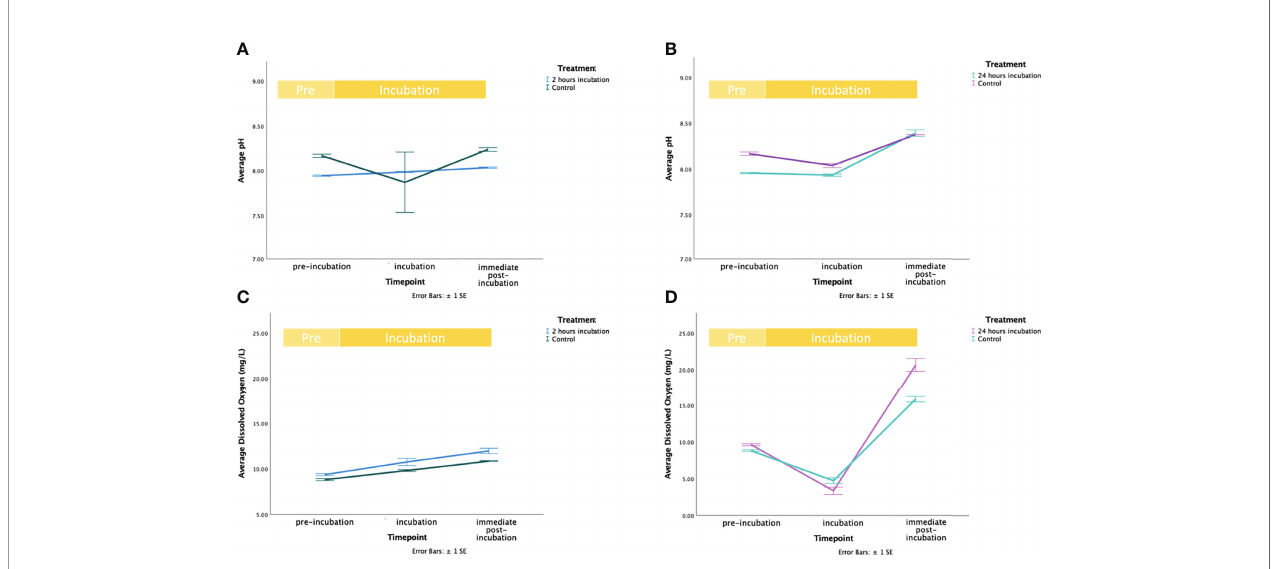
FIGURE 2 | Environmental parameters variation during the exposure of Cassiopea jelly fi sh to Magnesium Chloride (MgCl 2 ). In fi gures a, and c the green line represents the control, and the blue line represents the treatment. In fi gures b, and d, the mint line represents the control, and the purple line represents the treatment. (A) Fluctuations of average pH levels before the start ( “ pre-incubation ” ), middle ( “ incubation ” ) and end ( “ immediate post-incubation ” ) of the 2 hours exposure to MgCl 2 . Bars represent standard error (± 1SE). (B) Fluctuations of average pH levels before the start ( “ pre-incubation ” ), middle ( “ incubation ” ) and end ( “ immediate post-incubation ” ) of the 24 hours exposure to MgCl 2 . Bars represent standard error (± 1SE). (C) Fluctuations of average d O 2 levels before the start ( “ pre-incubation ” ), middle ( “ incubation ” ) and end ( “ immediate post-incubation ” ) of the 2 hours exposure to MgCl 2 . Bars represent standard error (± 1SE). (D) Fluctuations of average d O 2 levels before the start ( “ pre-incubation ” ), middle ( “ incubation ” ) and end ( “ immediate post-incubation ” ) of the 24 hours exposure to MgCl 2 . Bars represent standard error (±